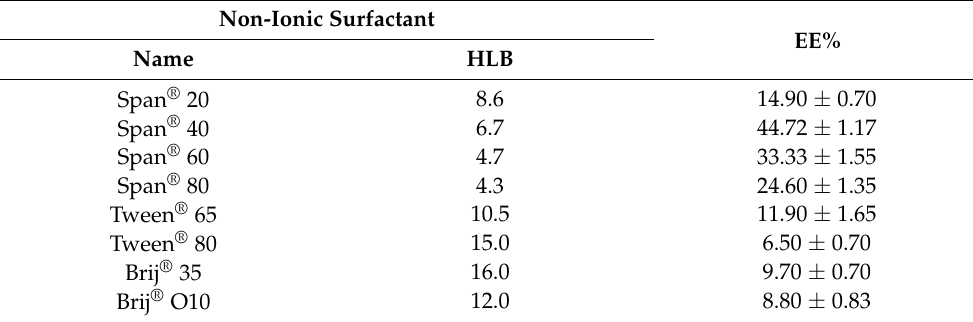
Table 3. Entrapment efficiency percent of zolmitriptan-loaded niosomes prepared using different non-ionic surfactants with different HLB